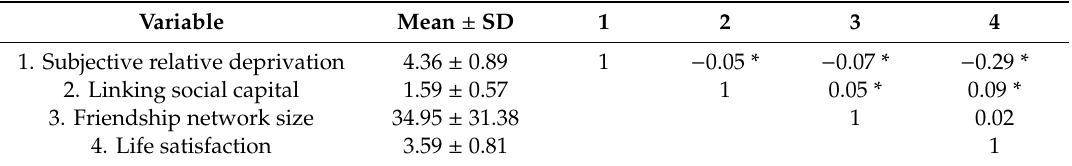
Table 2. Descriptive statistics and bivariate correlations of the study variables.